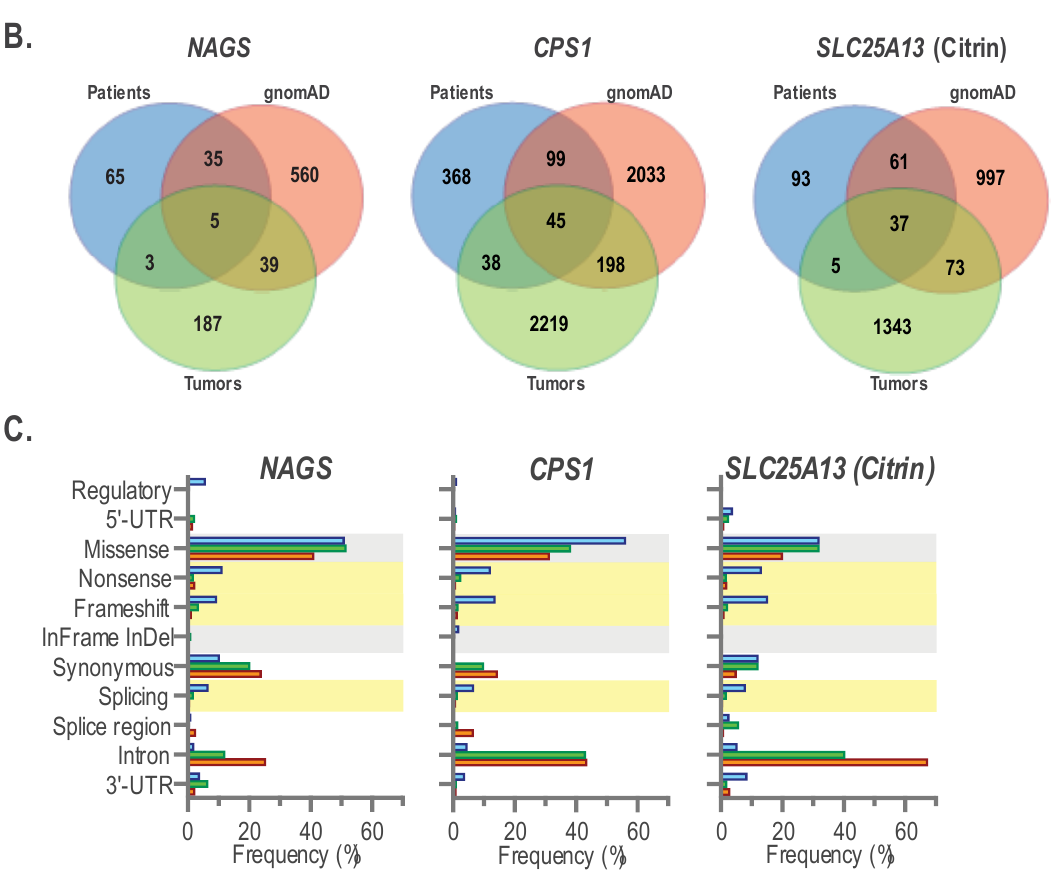
Figure 5. NAGS , CPS1 , and citrin single nucleotide variants and small indels in urea cycle patients, tumors, and individuals without rare genetic diseases. ( A ) Strategy used to collect and analyze sequence variants found in the three groups of samples. ( B ) Venn diagrams showing overlap between NAGS , CPS1 , or citrin sequence variants found in patients with respective deficiencies, tumors and gnomAD. ( C ) Distribution of NAGS , CPS1, and citrin variant types and their functional effects in patients (blue), tumors (green) and gnomAD (orange).